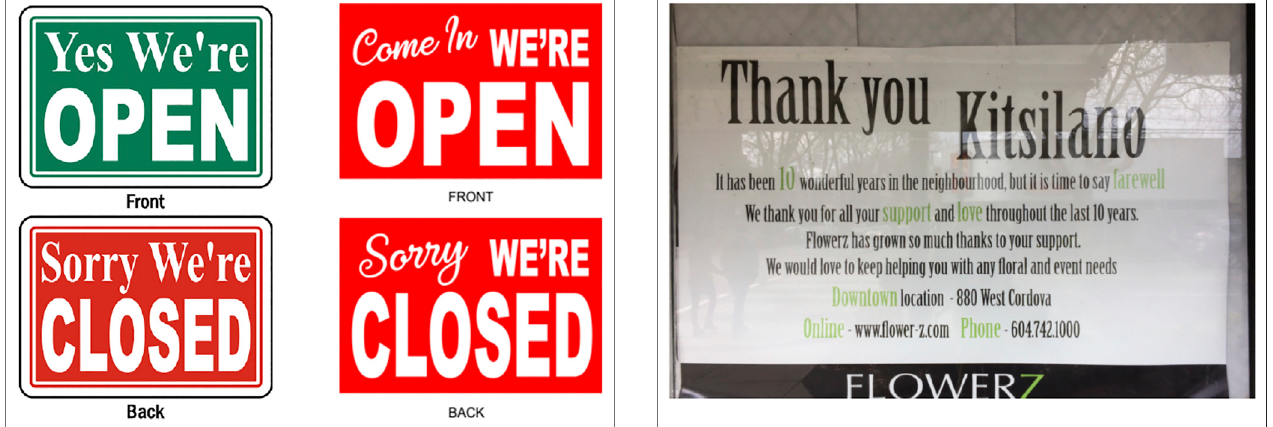
FIGURE 8 | A custom Thank you